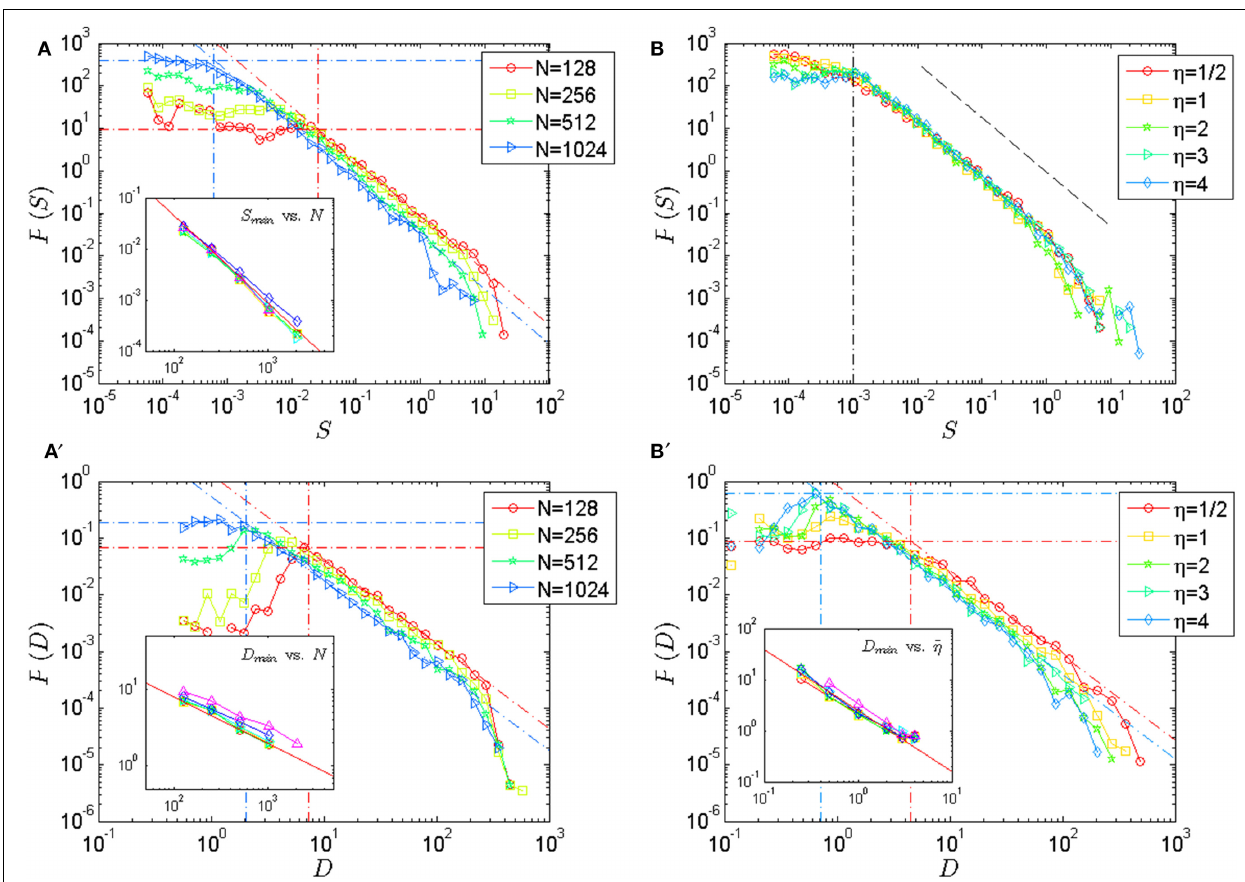
FIGURE 6 | Effect of the system size N and disorder strength ˜ η on the avalanche statistics. Main panel, top: Distribution of the avalanche size measured (A) fordifferent N atconstant c = 2 × 10 − 5 , k = 10 − 2 and ˜ η = 1,and (B) for different ˜ η at constant c = 2 × 10 − 5 , k = 10 − 2 and N = 1024. The axes are logarithmic. Main panel, bottom: Distribution of the avalanche duration measured (A (cid:6) ) for different N at constant c = 2 × 10 − 5 , k = 10 − 2 and ˜ η = 1, and (B (cid:6) ) for different ˜ η at constant c = 2 × 10 − 5 , k = 10 − 2 and N = 1024. All axes are logarithmic. In all panels, the power-law exponents τ and α are compatible with the universal values τ = 1 . 28 and α = 1 . 50 (inclined dashed line)predictedfor c → 0and k → 0.Regardingthesize,thelowercutoff S min is